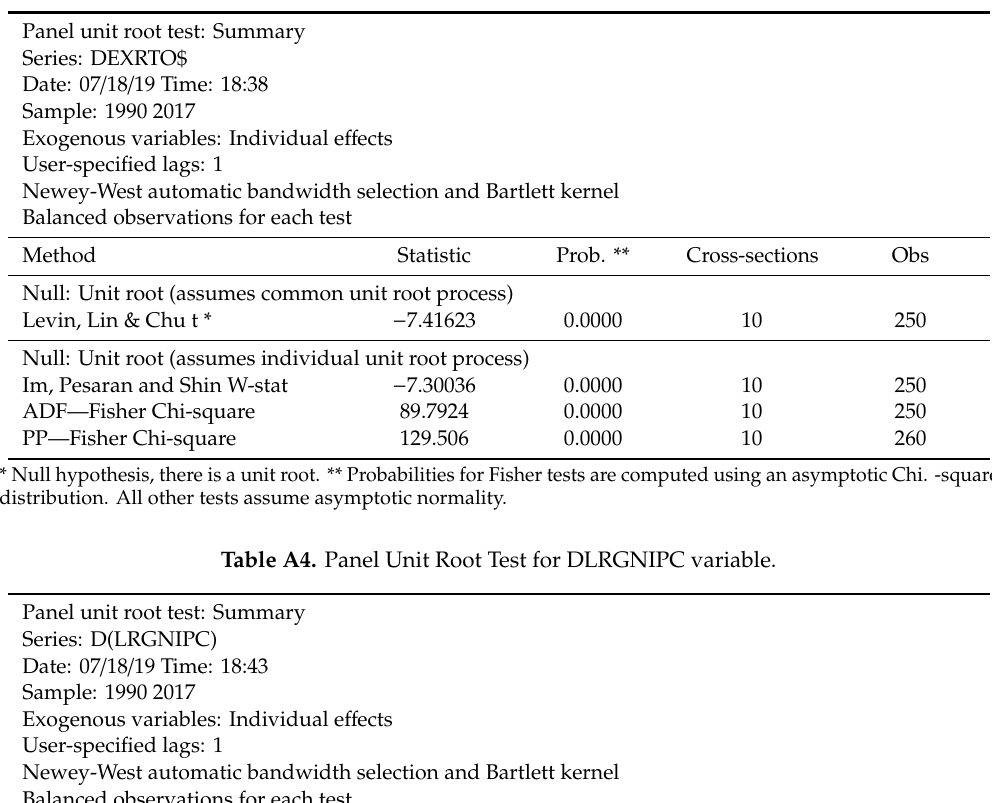
Table A3. Panel Unit Root Test for DEXRTO$ variable.